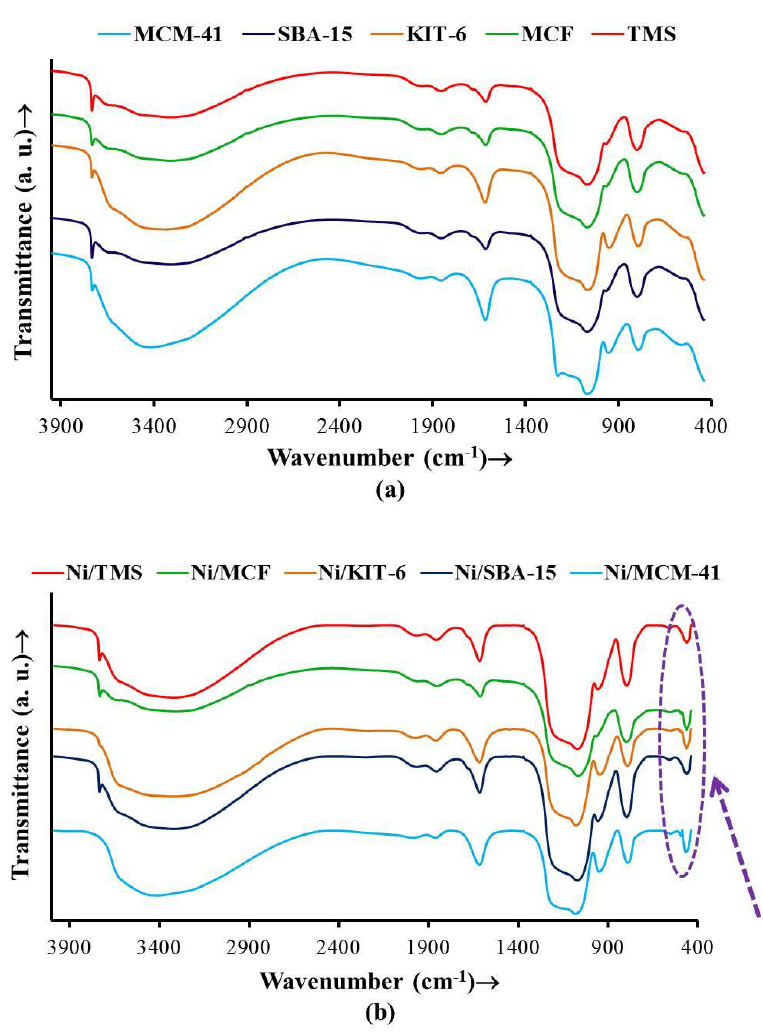
Figure 6. FTIR spectra of ( a ) the silica materials and ( b ) the Ni/SiO 2 catalysts.